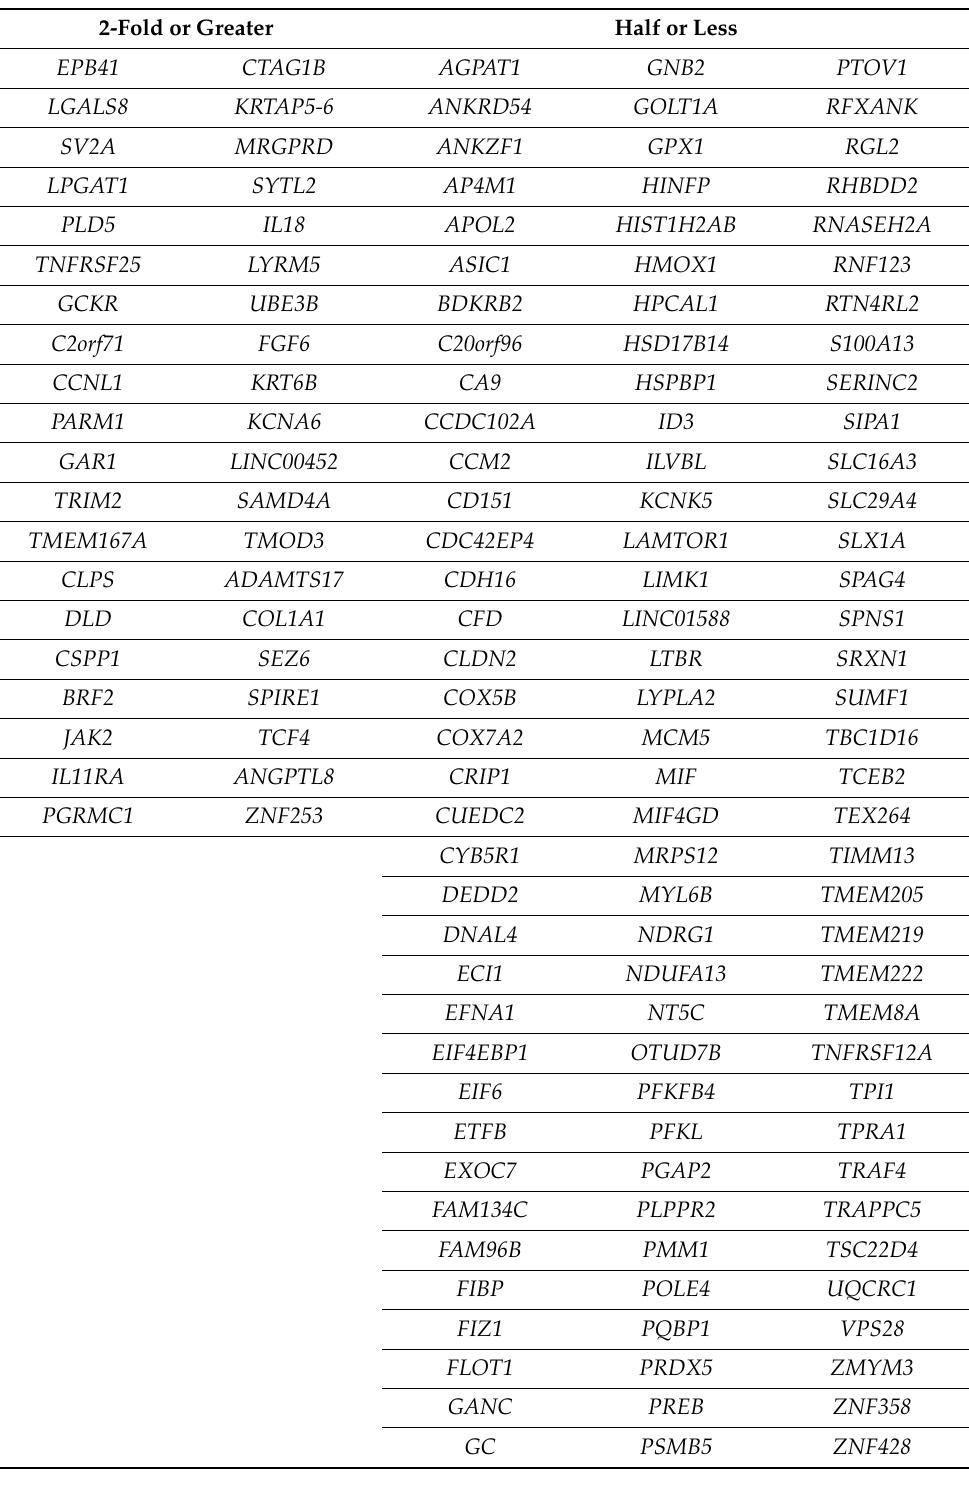
Table 3. List of genes upregulated or downregulated by CLDN2